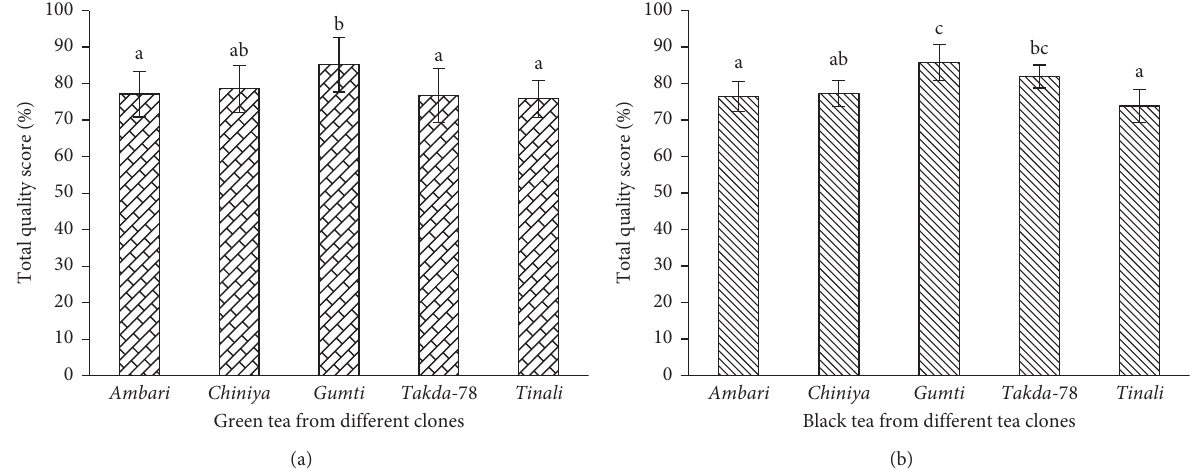
Figure 5: Percent total quality scores (TQS) for different varieties of (a) green tea and (b) orthodox black tea. Error bars show standard deviation and error bars bearing different superscripts are different ( p < 0 . 05) with one-way